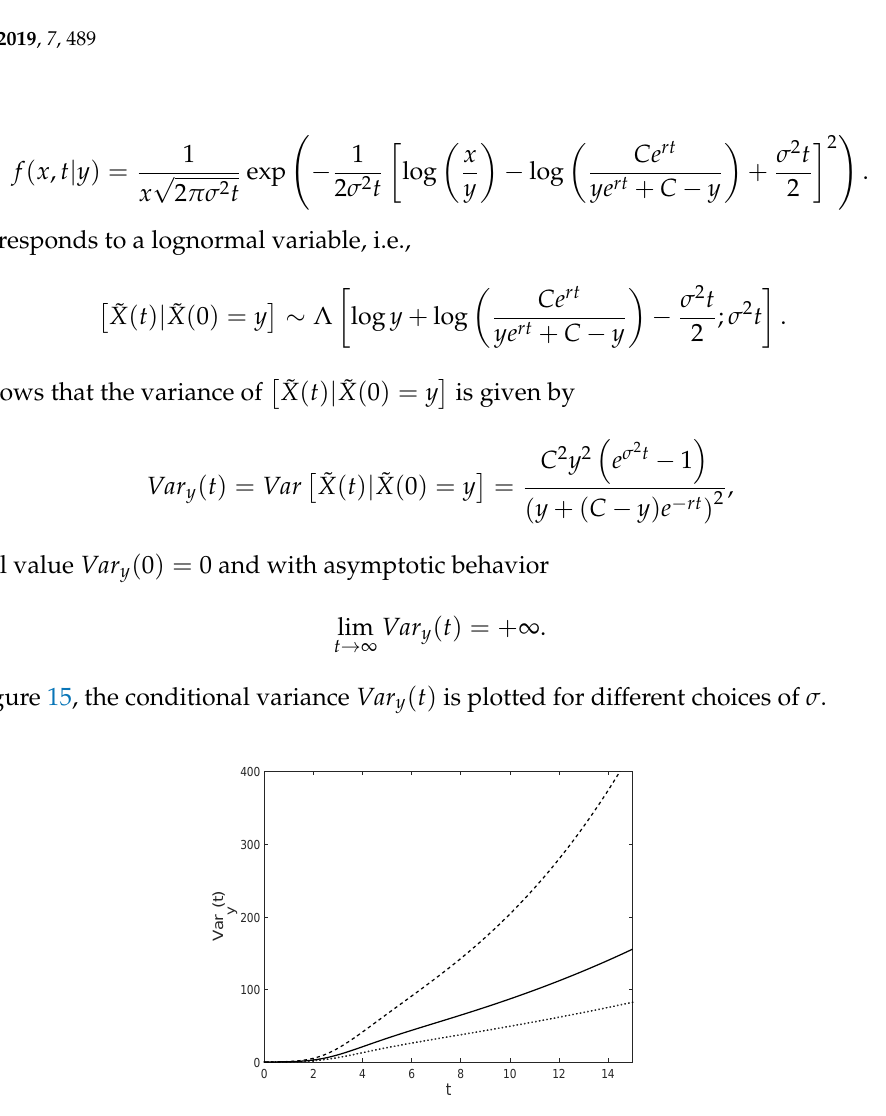
Figure 15. For y = 1, C = 10, r = 1 the conditional variance Var y ( t ) is plotted for σ = 1/4 (solid line), σ = 1/3 (dashed line) and σ = 1/5 (dotted line). Note that it is increasing with the respect to σ